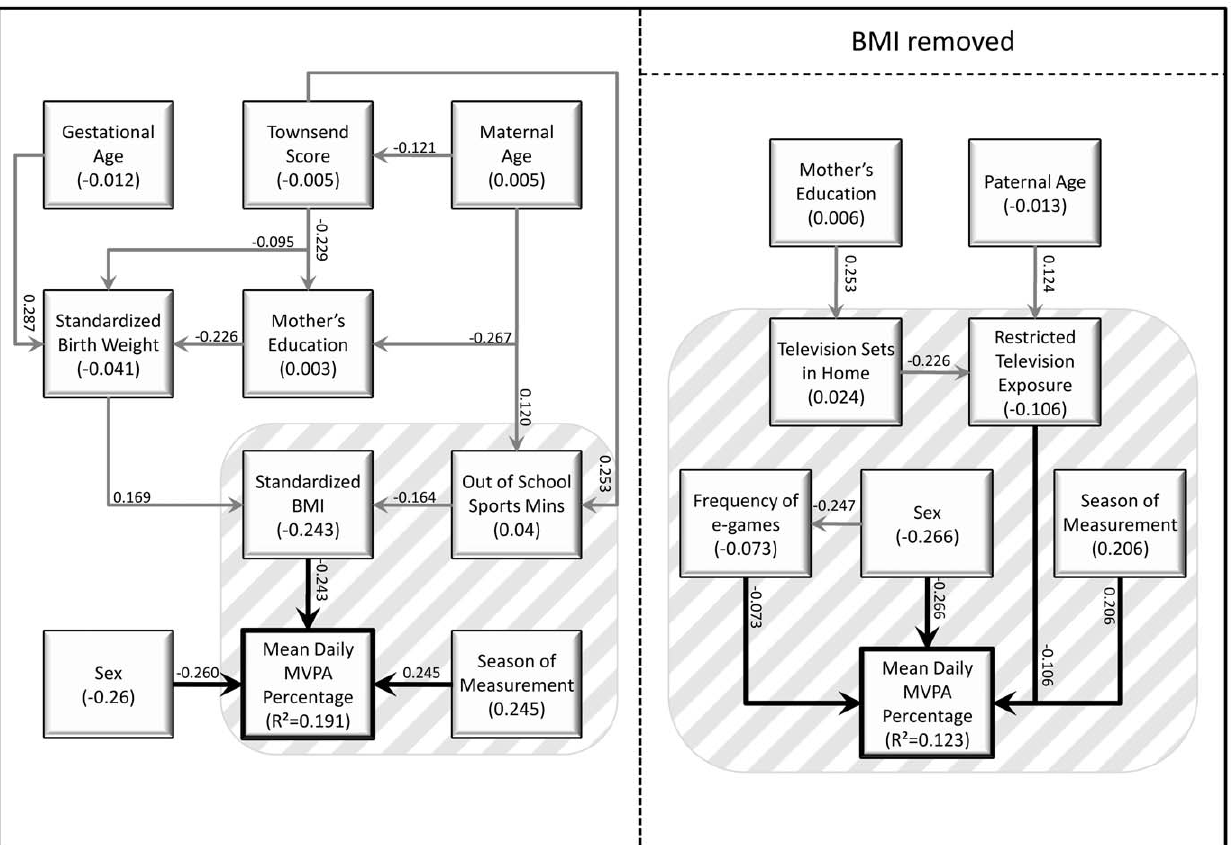
Figure 2. Path diagrams showing the direct and indirect predictors of percent of time spent in MVPA, with and without the inclusion of standardised BMI of the child.